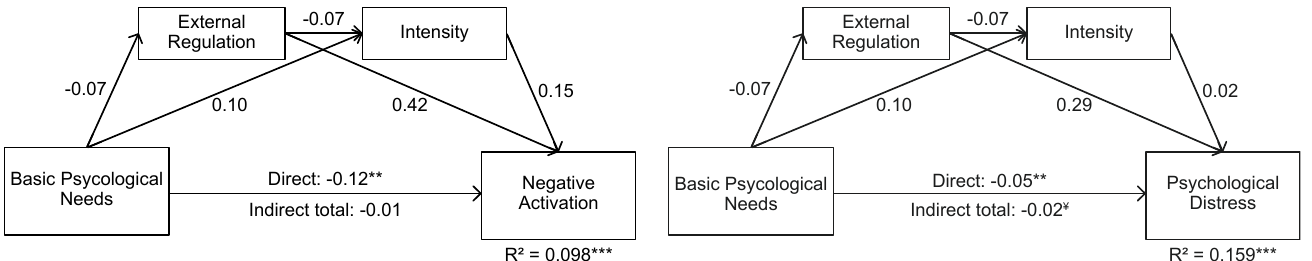
Figure 3. Serial mediation models for basic psychological needs, external regulations and negative emotional